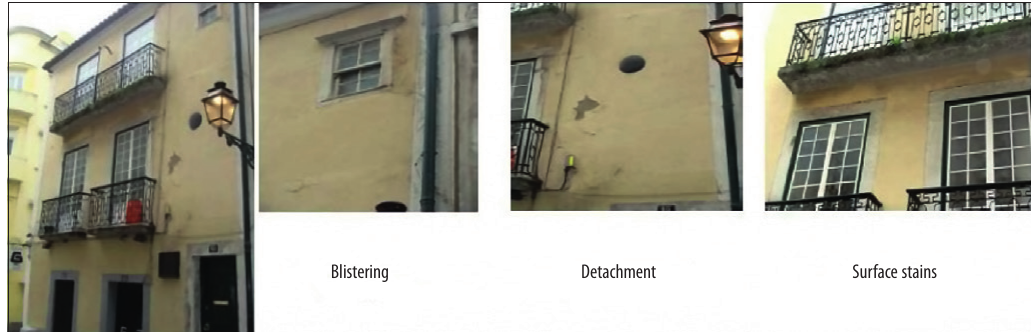
Fig. 2. Case study representative of the end of the service life of façade paintings (degradation severity around